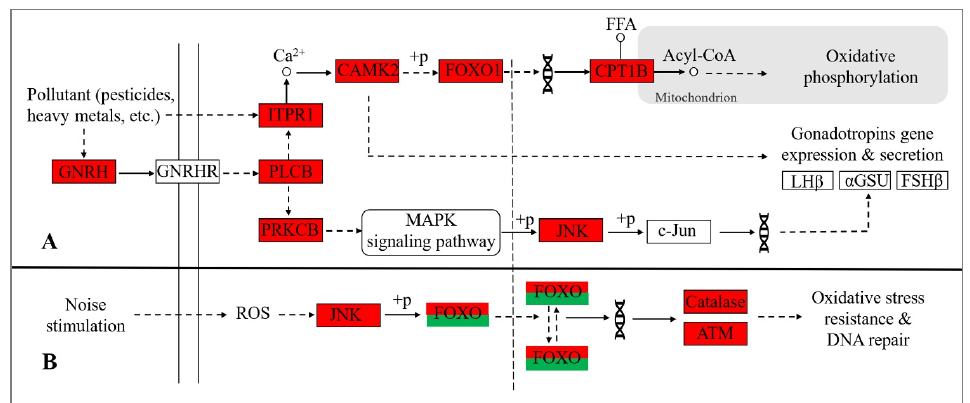
Figure 4. Functional significance of differentially expressed key genes in two groups of Yangtze finless porpoise. Red represents upregulation in CJ group and green represents downregulation. Solid arrows indicate activation processes, dashed arrows indicate indirect activation processes. ( A ) The relationship between water pollution and endocrine gene expression. GNRH , gonadotropin releasing hormone; GNRHR , gonadotropin releasing hormone receptor; ITPR1 , inositol 1,4,5-trisphosphate receptor type 1; CAMK2 , calcium/calmodulin dependent protein kinase II; FOXO , forkhead box O; CPT1B , carnitine palmitoyltransferase 1B; PLCB , phospholipase C beta; PRKCB , protein kinase C beta; JNK ( MAPK8/9 ), mitogen-activated protein kinase 8/9; c-Jun , transcription factor AP-1. ( B ) The relationship between noise stimulation and gene expression in FOXO pathway. Catalase ( RASGEF1A ), RasGEF domain family member 1A; ATM , ATM serine/threonine